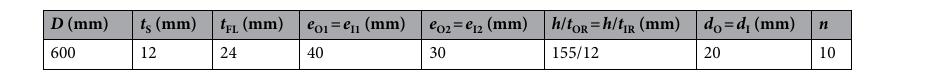
Table 1. Geometric dimensions of specimens.